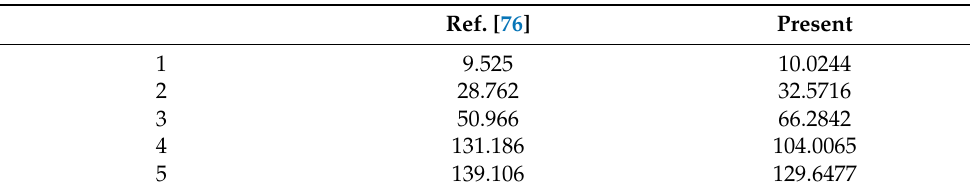
Table 3. Dimensionless natural frequencies ¯ ω of a simply supported rectangular FG plate composed of BaTiO 3 /CoFe 2 O 4 .